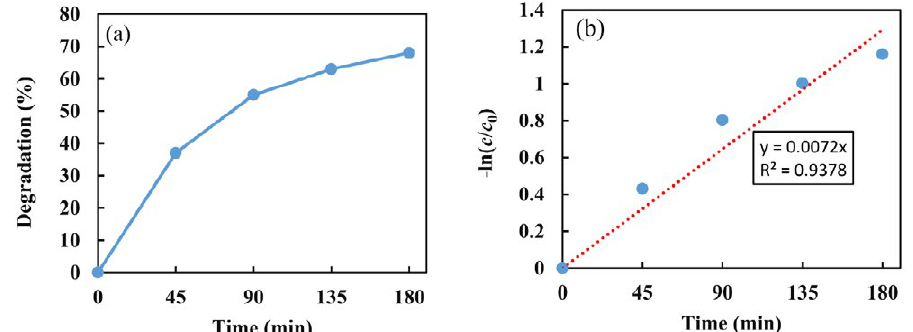
visible light irradiation for 180 min.